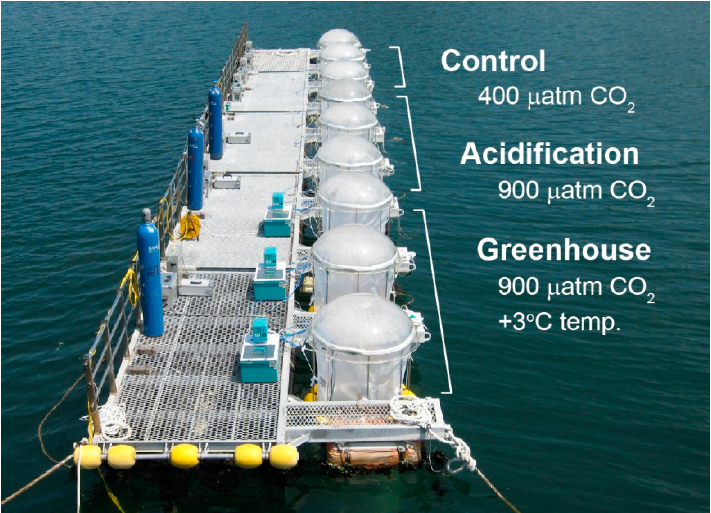
Figure 1. Photograph of the floating raft, pCO 2 concentration regulation units, temperature regulation units, and enclosures of the mesocosm facility. Design and performance of the facility have been described in detail elsewhere [26,27].